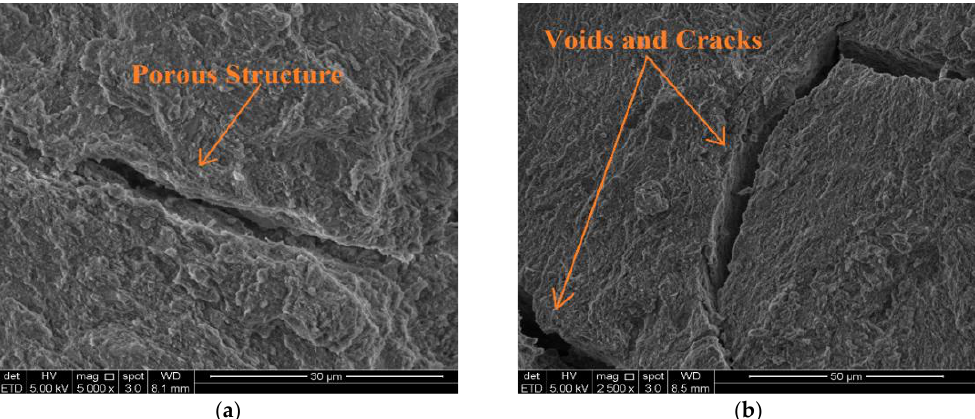
Figure 9. ( a , b ) SEM images of the soil treated by cement after 28 days of curing period.